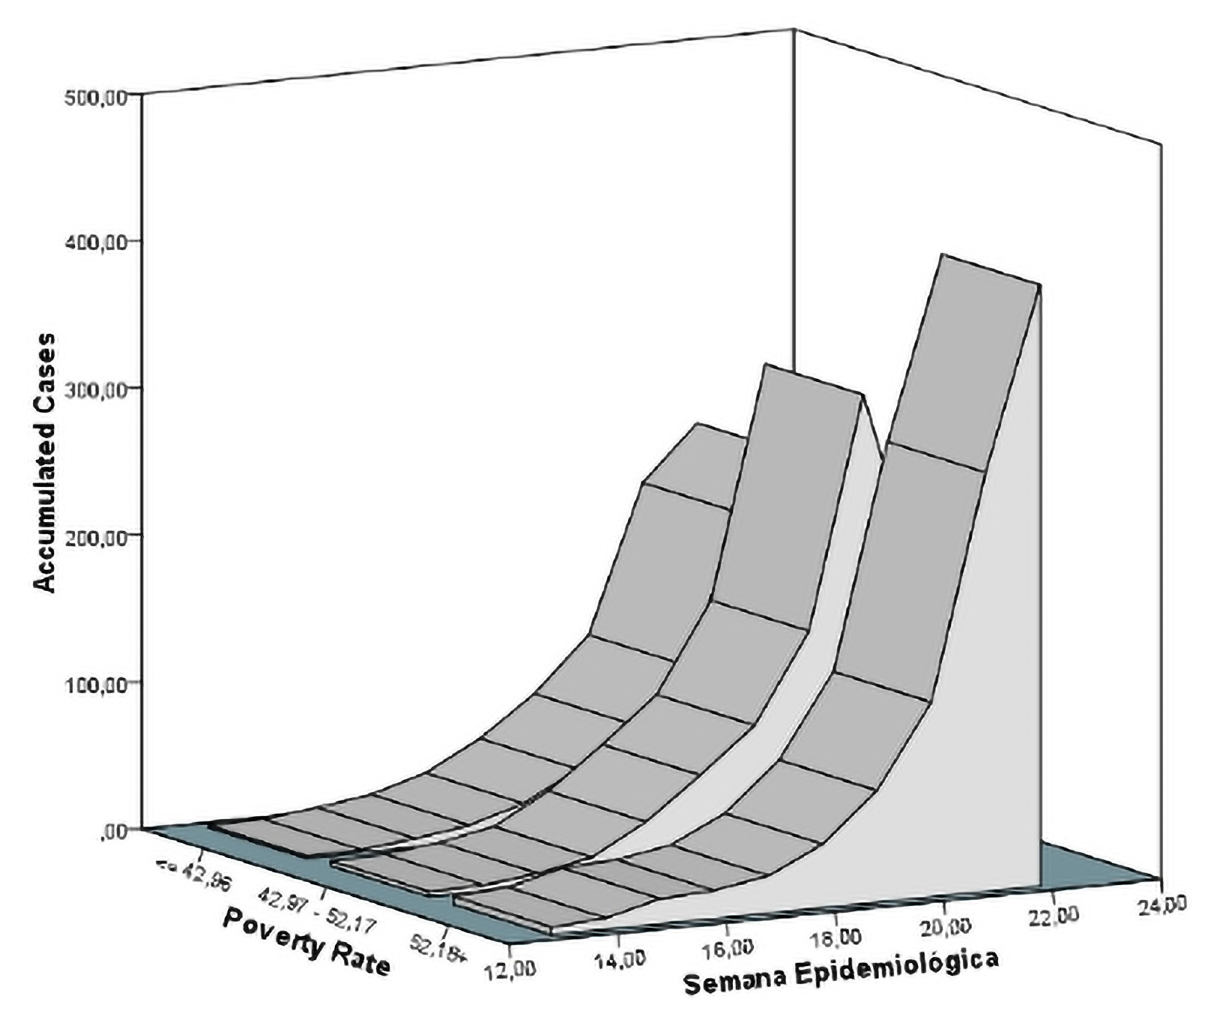
Fig 3. Temporal distribution of COVID-19 cases stratified by the poverty incidence.